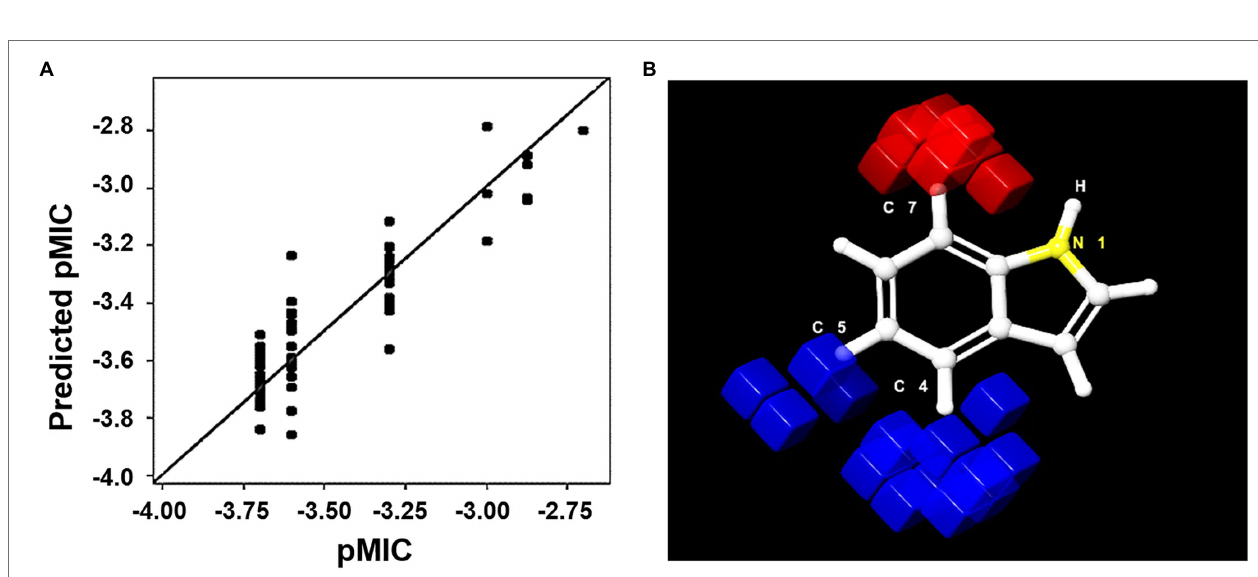
FIGURE 7 | (A) Scatter plot of pMIC vs. predicted pMIC for the 73 indole derivatives, predicted by 3D-QSAR PLS factor 5 model. (B) 3D representation of positive (blue) and negative (red) positions of the indole moiety for MIC activity.